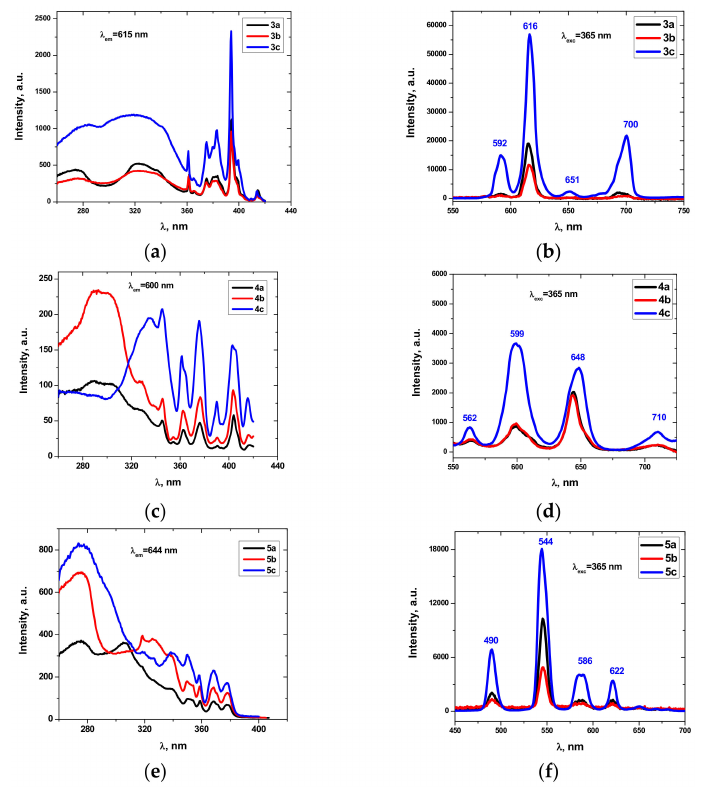
Figure 6. The excitation and emission spectra of the lanthanide complexes measured in solid-state at room temperature (the wavelengths used for excitation and emission are indicated on each plot): europium(III) complexes, excitation ( a ) and emission spectra ( b ); samarium(III) complexes, excitation ( c ) and emission spectra ( d ); terbium(III) complexes, excitation ( e ) and emission spectra ( f